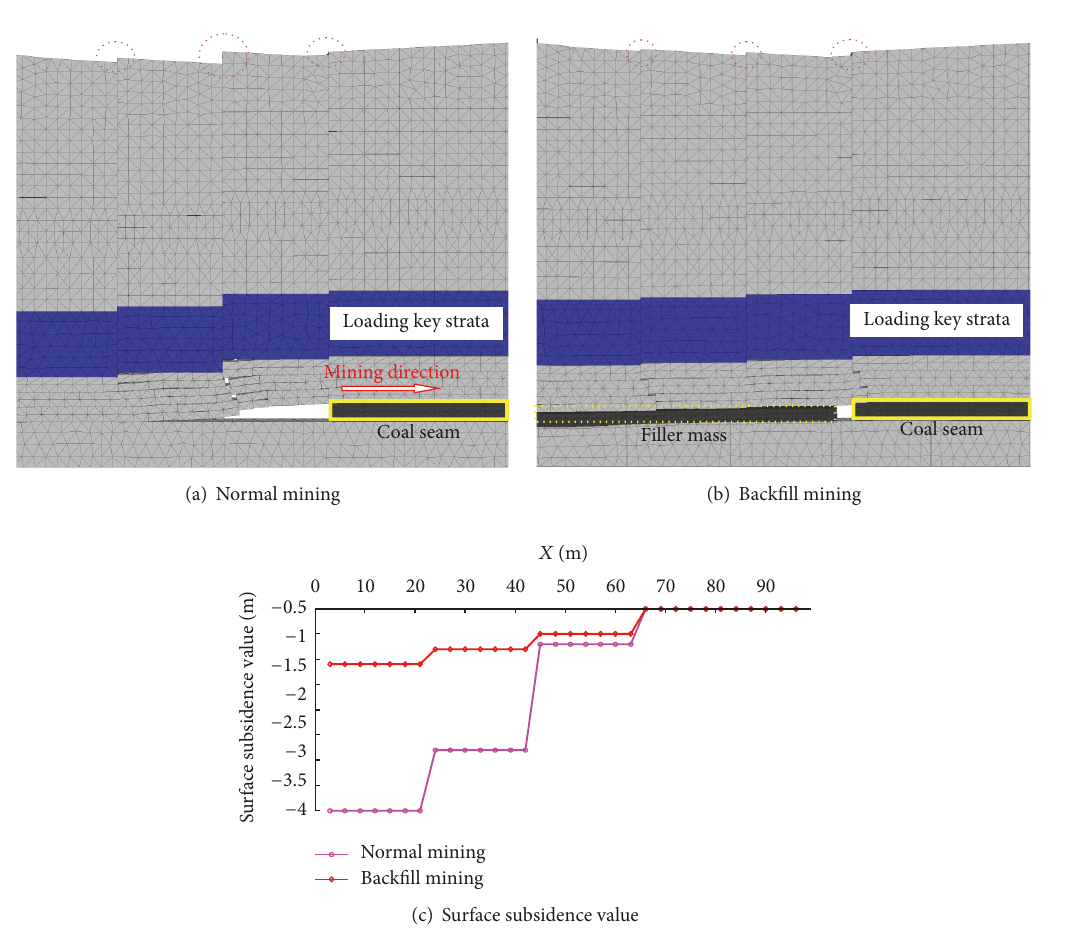
Figure 15: Control effect of backfill mining on morphological development of surface mining-induced